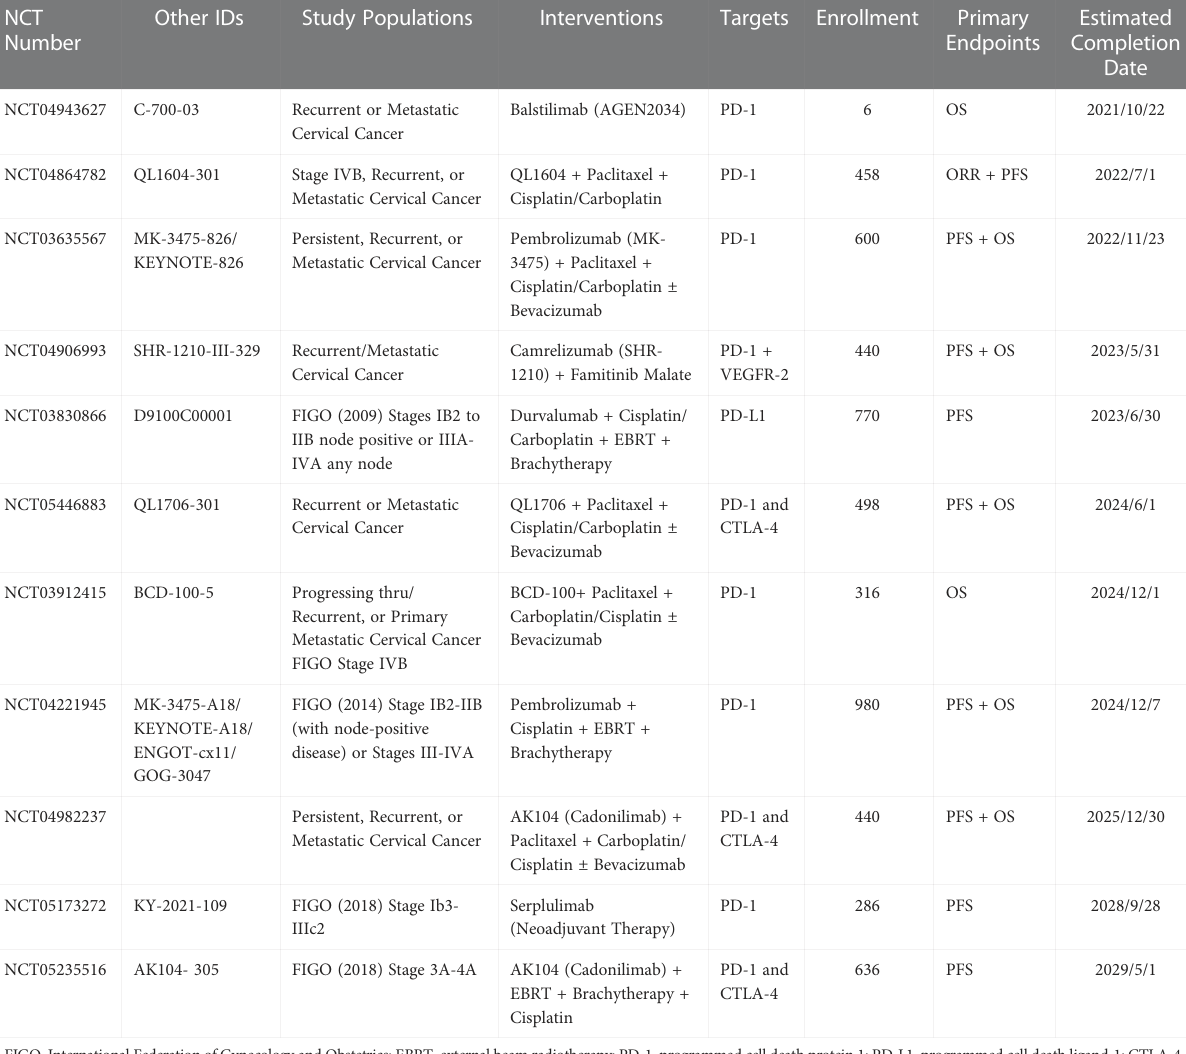
FIGO,InternationalFederationofGynecologyandObstetrics;EBRT,externalbeamradiotherapy;PD-1,programmedcelldeathprotein1;PD-L1,programmedcelldeathligand-1;CTLA-4, cytotoxic T-lymphocyte-associated protein 4; VEGFR-2, vascular endothelial growth factor receptor 2; PFS, progression-free survival; OS, overall survival; ORR, objective response